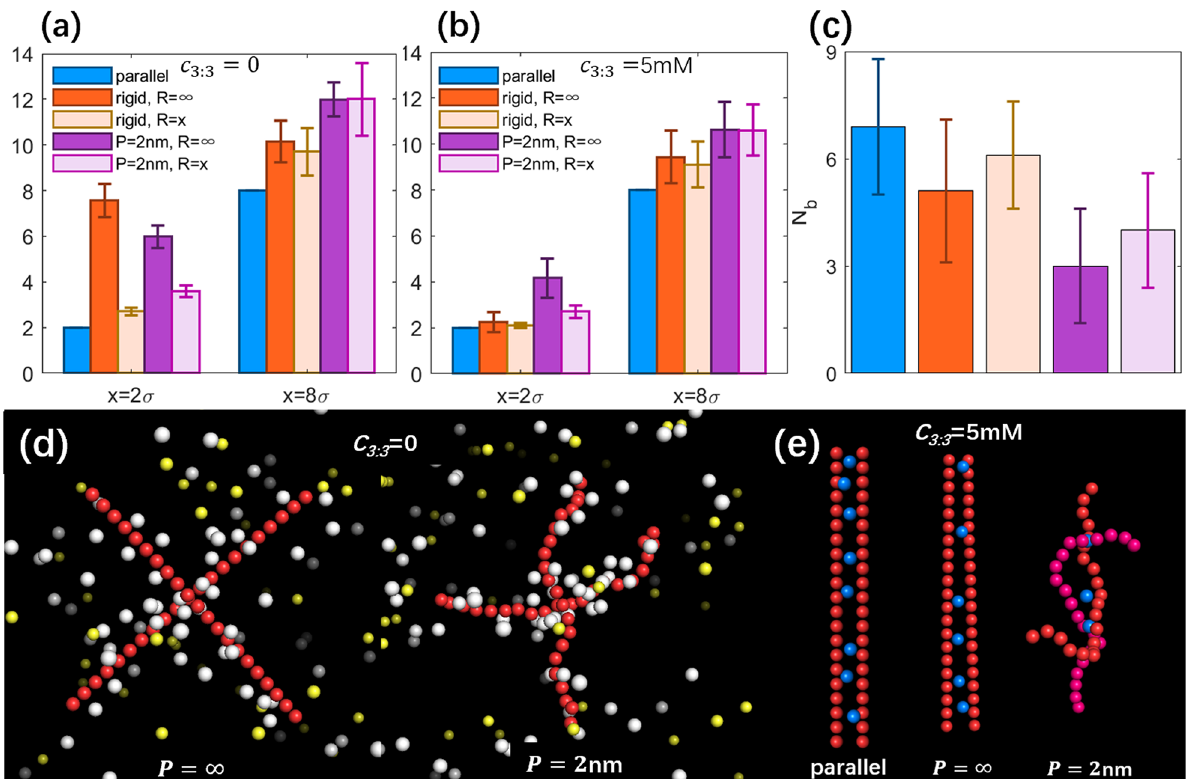
Figure 6. ( a , b ) Effective separation D between the two PEs for two typical salt conditions: c 3:3 = 0 ( a ) and c 3:3 = 5 mM ( b ), in the absence of the cylinder confinement. Error bars represent the corresponding standard deviation Δ D . ( c ) Number N b of the bridging ions for PEs with different persistence lengths P at c 3:3 = 5 mM. Error bars represent corresponding standard deviation Δ N b . Please note that the systems were always in the presence of 20 mM 1:1 salt buffer. ( d , e ) Typical conformations of PEs with different persistence lengths P in the absence of cylindrical confinement. ( d ) c 3:3 = 0, and white and yellow spheres represent monovalent cations and monovalent anions. ( e ) c 3:3 = 5 mM, and the notation is the same as in Fig. 3. For P = 2 nm, the color of one PE is adjusted to pink to make it more distinguishable from the